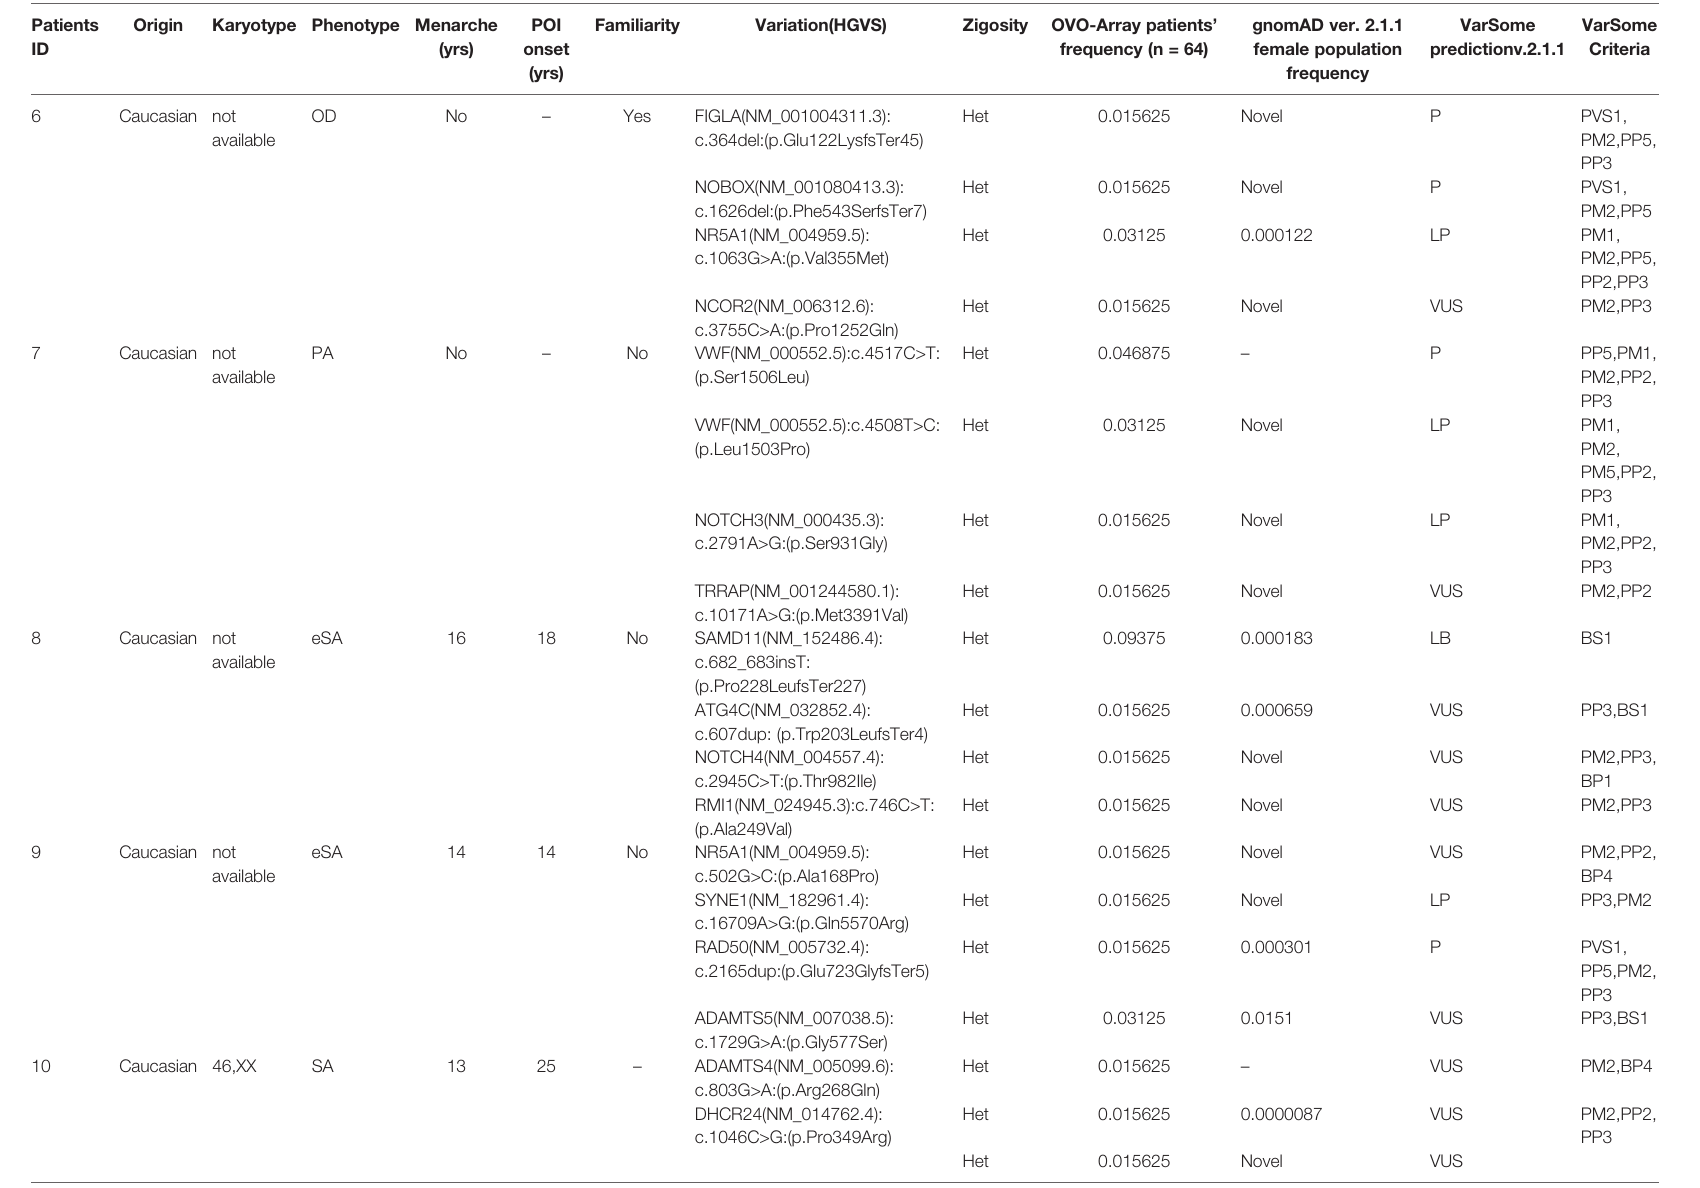
TABLE 3 | Correlation among severity, phenotype and pathogenicity predictions in patients with 4 variants in potentially POI